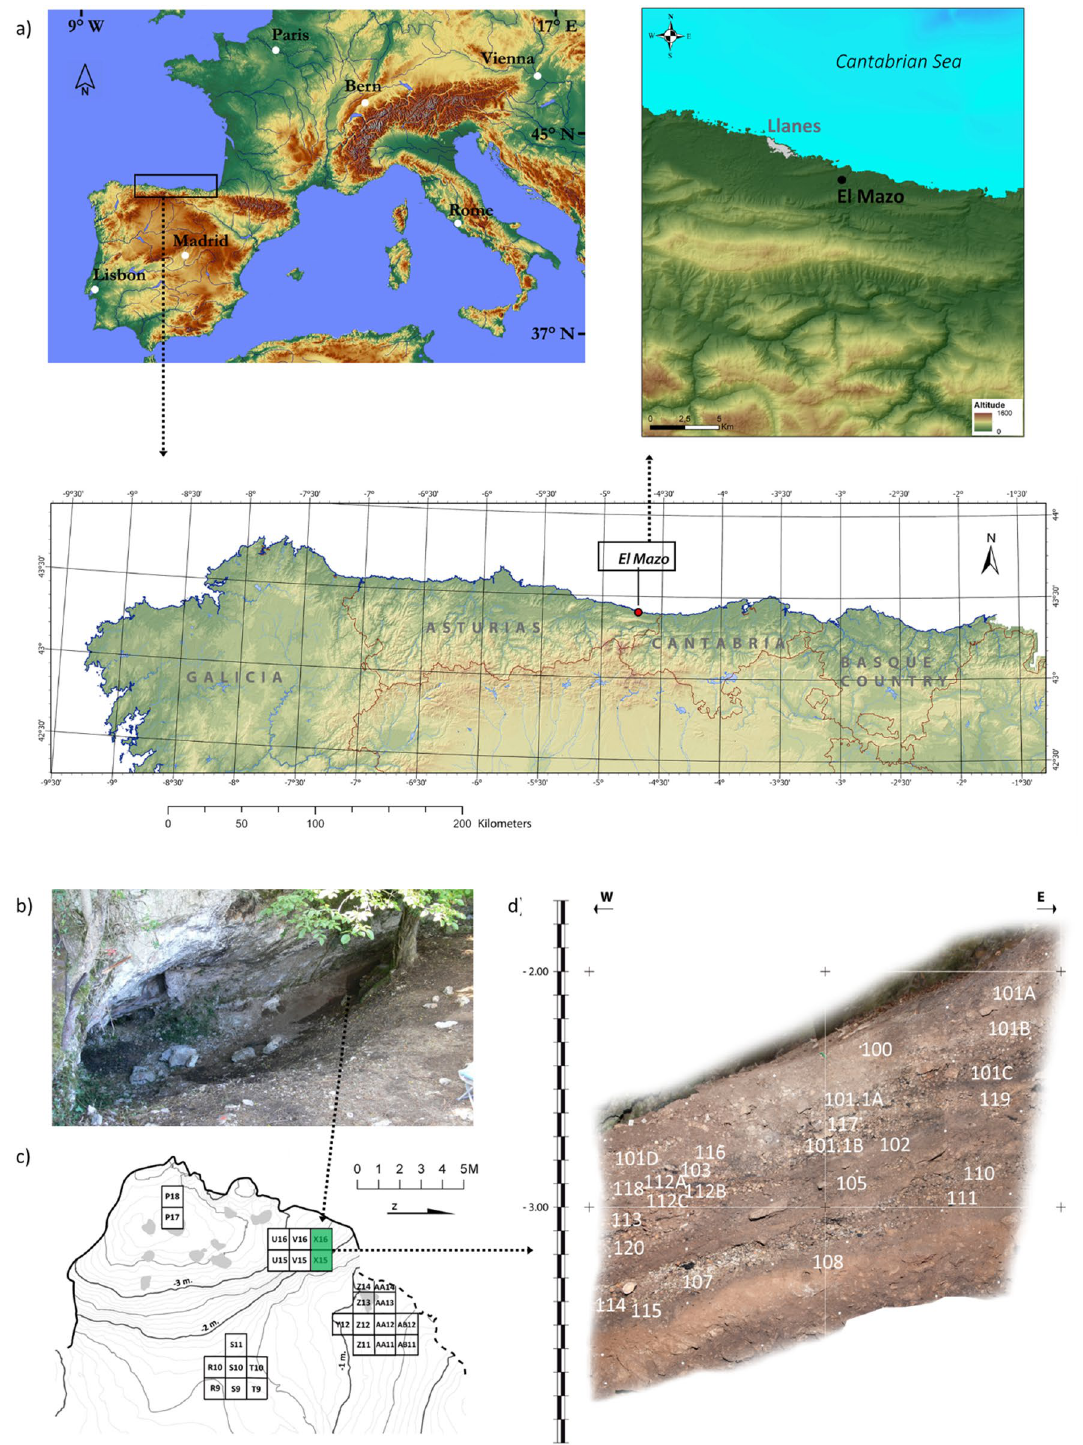
Figure 1. ( a ) Location of the study area (Cantabrian region, northern Spain) and the shell midden site of El Mazo. ( b ) External view of El Mazo; ( c ) topographic map of the site showing excavation areas and provenance of the studied samples (shaded squares), and ( d ) stratigraphy of the inner test pit (squares X15 and X16). Satellite map in the upper-left corner of ( a ) was created by authors using Adobe® Illustrator software. The original base map was extracted from the maps-for-free web site (https:// maps- for- free. com/) (© Collaborators of OpenStreetMap, Open Database License [ODbL]). Map in the upper-right corner of ( a ) was generated by Alejandro Garcia-Moreno using ArcGIS software. Lower map of ( a ) was created by Luis C. Teira Mayolini using ArcGIS and Adobe Suite